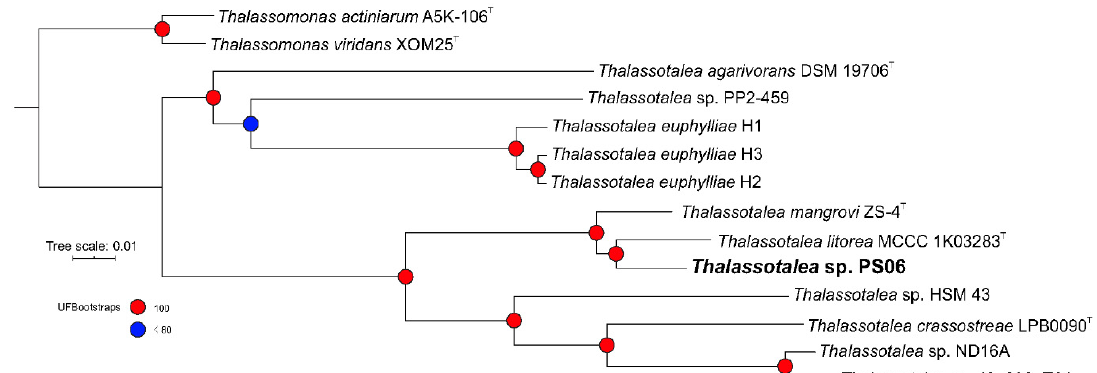
Figure 1. Phylogenomic tree based on draft or complete genomes of PS06, members of the genus Thalassotalea , and two Thalassomonas spp. Maximum likelihood phylogenies were inferred from 14 genomes. The PS06 genome is highlighted in bold. The strength of support for internal nodes was assessed by bootstrap resampling, and values are shown as colored circles (see legend). Midpoint rooting was used.